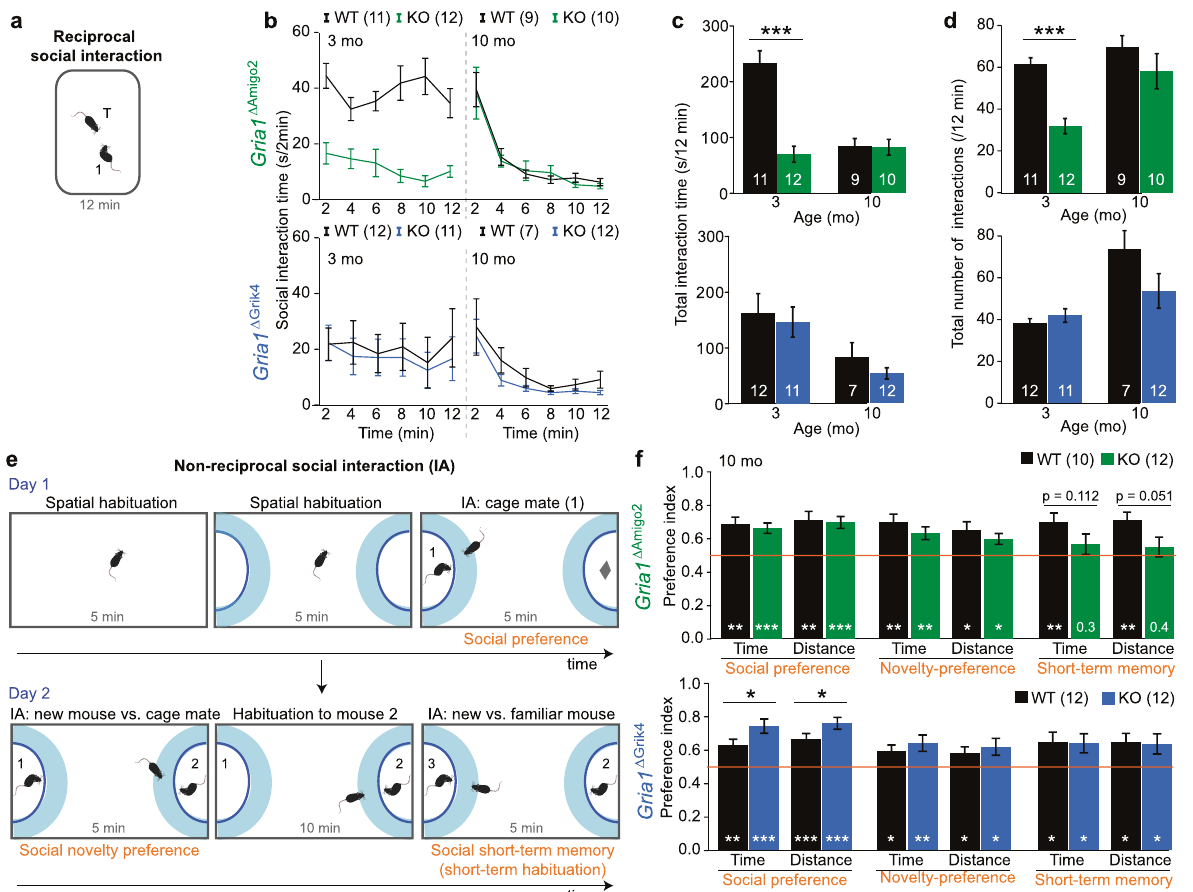
Fig. 4 Ablation of GluA1 from CA2/CA3 alters social behaviour. a Illustration of reciprocal social interaction assay; see 'Methods'. b Social interaction time in 2 min of intervals in the cohorts named on the left for the 12 min of exposure, tested at two different ages (stated in the upper left corner). c Same as ( b ) but summed up total interaction time. d Total number of interactions in 12 min. e Illustration of phases of 3-chamber task (omitting habituation to small compartments on the prior day and a 5 min habituation phase on day 2); see 'Methods'. f Preference indexes for the three test phases named in orange in ( e , f ) each calculated either from the time spent in the interaction zone around the lateral compartments (cyan in ( e )), or from the distance the head of the animal moved inside the interaction zone, as stated. The social preference refers to the preference for the compartment with a cagemate compared to the compartment with a mouse-sized object, as determined in the last phase of day 1. Novelty preference refers to the preference for an unknown mouse compared to a cagemate. Short- term memory refers to the preference for another novel mouse compared to the mouse that has become familiar across the two immediately prior phases on day 2. All data shown in ( b – d , f ) are from male mice, and the cohort is identi fi ed on the left of ( b , f ) and colour-coded, with KO mice and control groups of each cohort in colour and black, respectively. N -numbers are stated in colour legends or bars of each panel, see Supplementary Tables 3 and 4 for statistics; the two cohorts were treated separately for statistical comparison between wild-type and control data with univariate ANOVAs. White stars and numbers indicate the result of the one-sample t -test against chance level (orange line). See Supplementary Tables 3 and 4 for exact statistical results. All graphs show mean ± s.e.m. *** P < 0.001, ** P < 0.01, * P < training protocol (stage 5), the mice were tested in fi ve different challenge protocols that demanded elevated sustained attention (due to a reduction of the stimulus duration to 1 s or 0.8 s, or pseudo-random auditory distraction) or impulse control (either due to a fi xed extension of the ITI to 9 s or a pseudo-randomly varied extension of the ITI-duration; Supplementary Table 6). Gria1 Δ Amigo2 mice did not show any major alterations across the parameters assessed by the 5-CSRTT including parameters for sustained attention (accuracy), impulsivity (premature respond- ing), task engagement (omission rates), motivation (reward latency), or general performance (number correct responses;